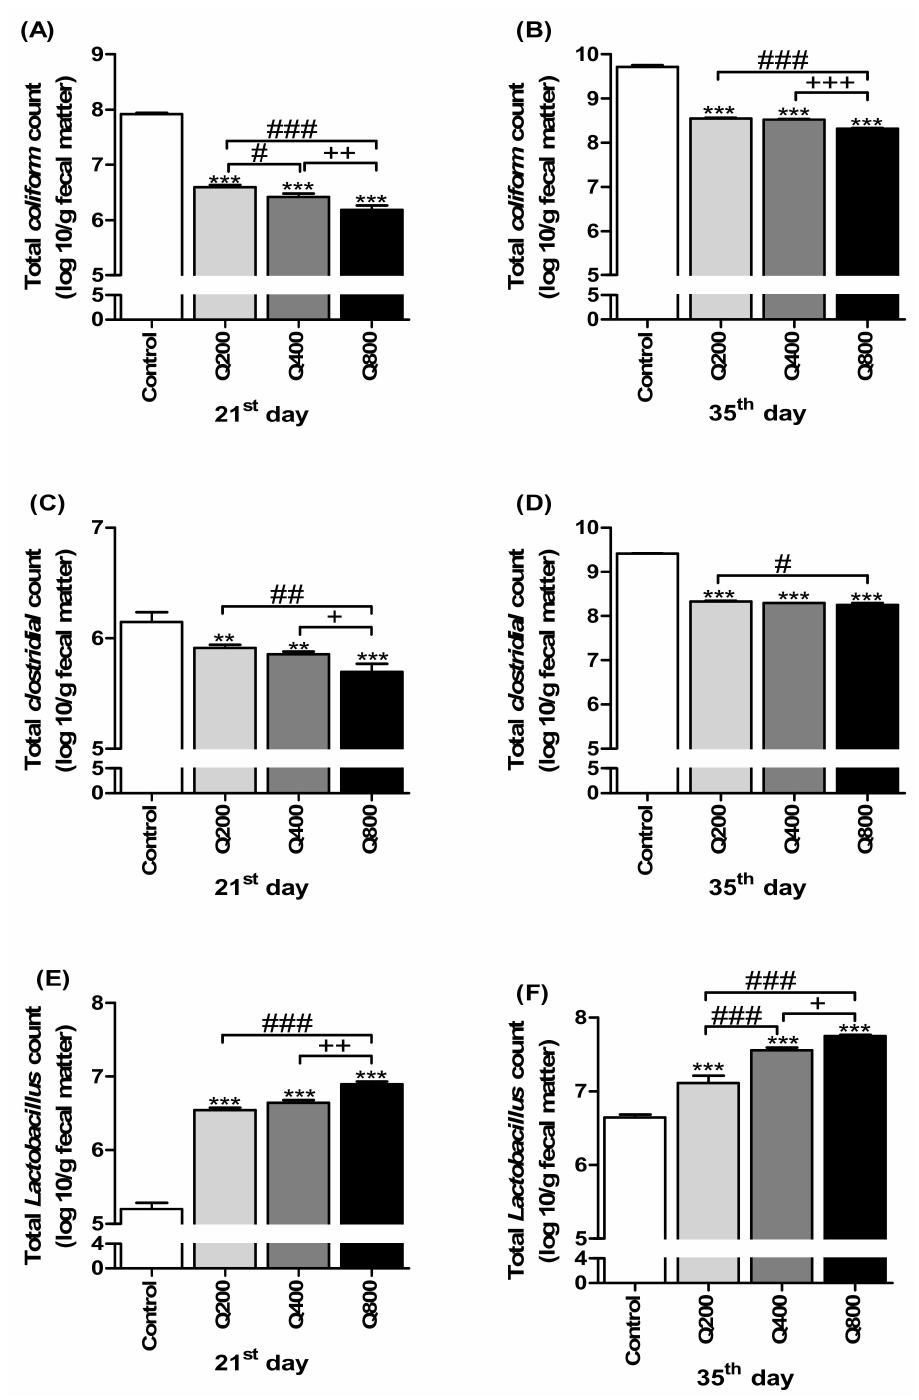
Figure 1. Total coliform ( A,B ), C. perfringens ( C,D ), and Lactobacillus ( E,F ) counts in fecal samples. ** p < 0.01 and *** p < 0.001 vs. control. # p < 0.05, ## p < 0.01, and ### p < 0.001 vs. Q200. + p < 0.05, ++ p < 0.01, and +++ p < 0.001 vs. Q400. Statistical analysis was performed using one-way ANOVA and Tukey’s post hoc test for multiple comparisons. Q200, birds fed 200 ppm. Q400, birds fed 400 ppm. Q800, birds fed 800